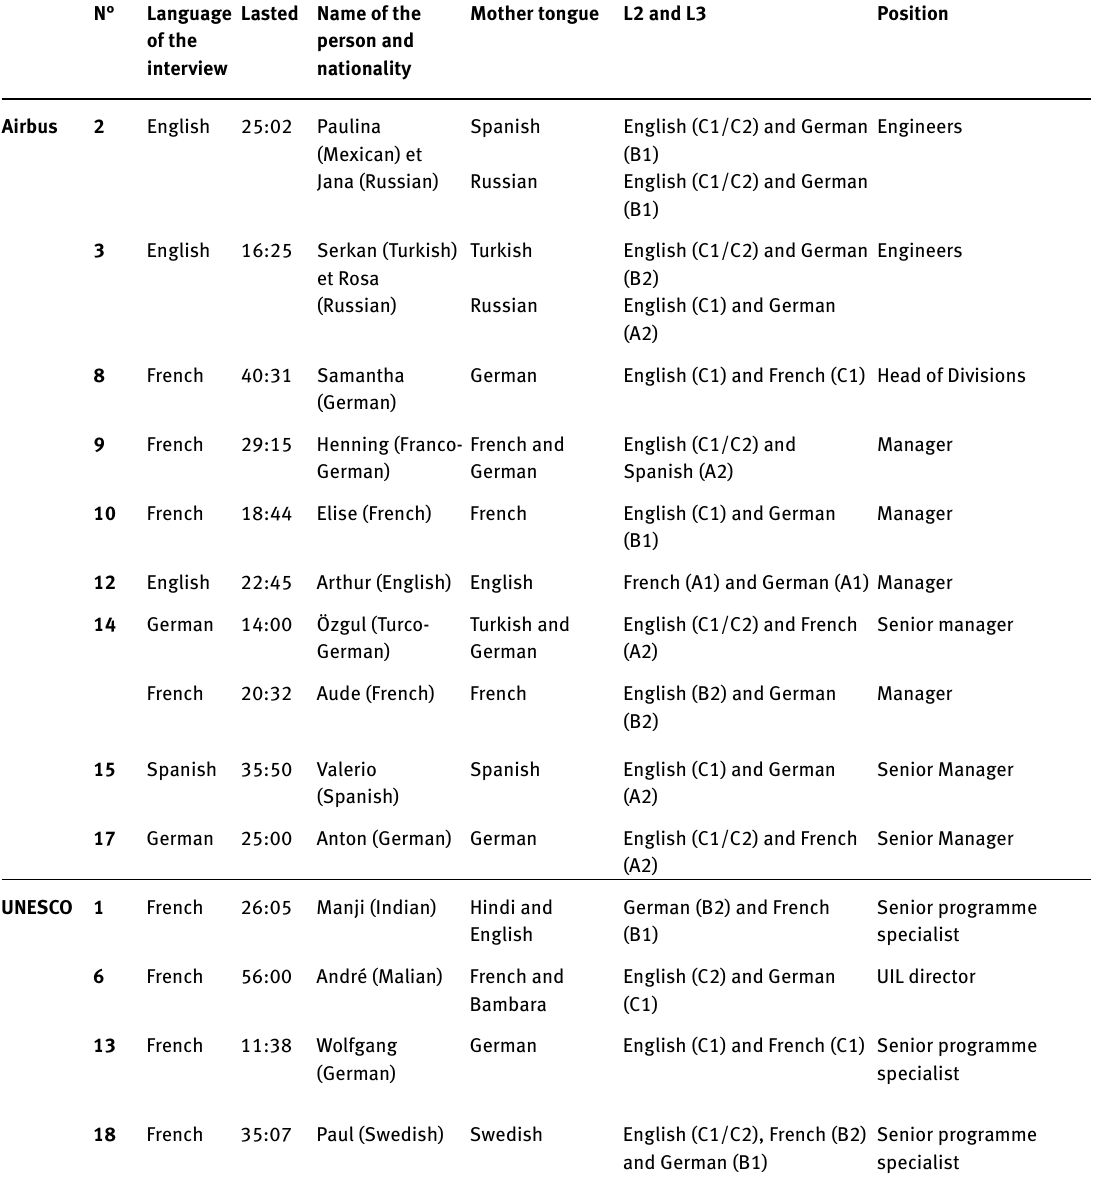
Table 1. Interviews Airbus, Unesco of the interview